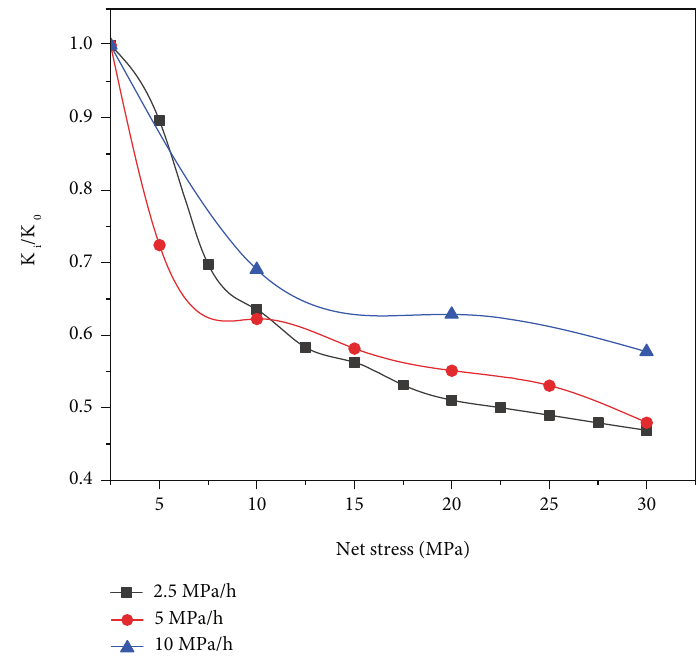
Figure 5: The relation between permeability and the net stress under di ff erent loading